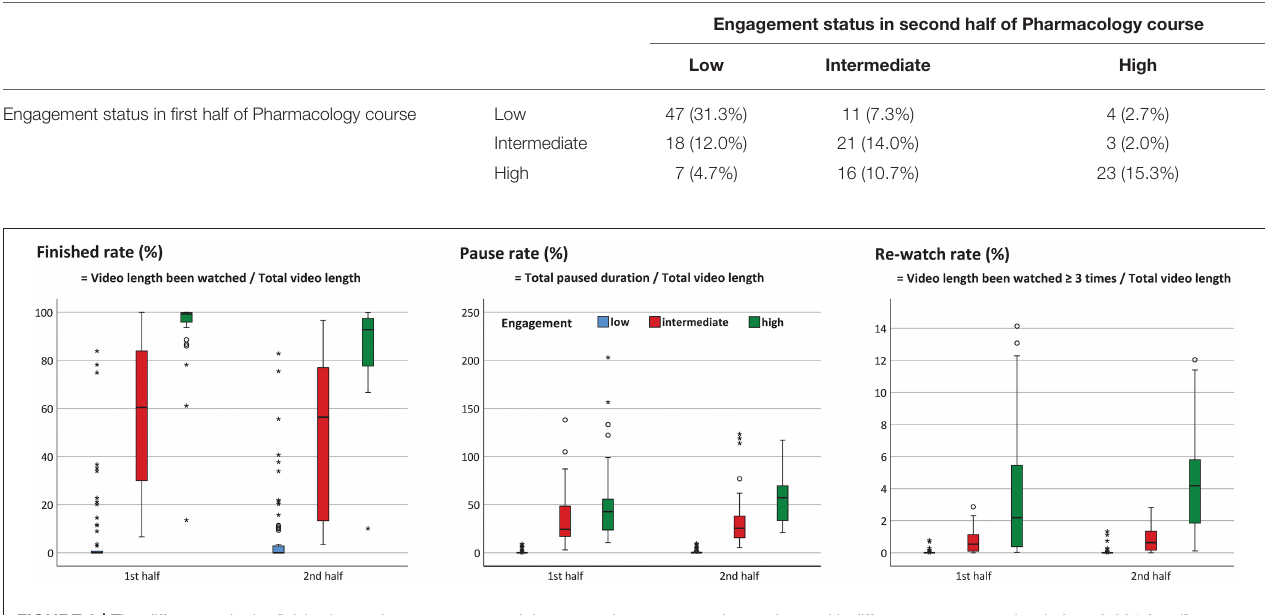
TABLE 2 | Correlations between the engagement status in first and second half of Pharmacology course (Pearson correlation coefficient = 0.557).